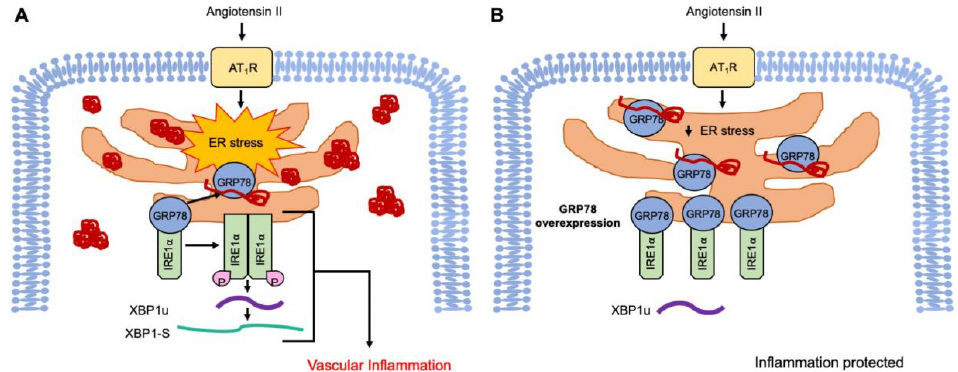
Figure 5. Proposed mechanisms for GRP78 mitigation of AngII-induced dysfunctional proteostasis and subsequent vascular inflammation. ( A ) Angiotensin II (AngII) via angiotensin II type 1 receptor (AT1R) induces ER stress. The proteostasis mechanism appears insufficient leading to protein aggregation in VSMC. GRP78 detaches from IRE1α to bind nascent misfolded peptide chains, and in turn leads to IRE1α dimerization and autophosphorylation. This leads to XBP1-S alternative splicing and potential UPRosome initiation, which activates VSMC proinflammatory phenotype, contributes to immune cell infiltration in the vasculature, and the overall progression of CVD. ( B ) The overexpression of GRP78 mitigates peptide misfolding into aggregates under AngII stimulation, while also curbing UPR signaling by maintaining its attachment to IRE1α and protecting monocyte adhesion/vascular inflammation.